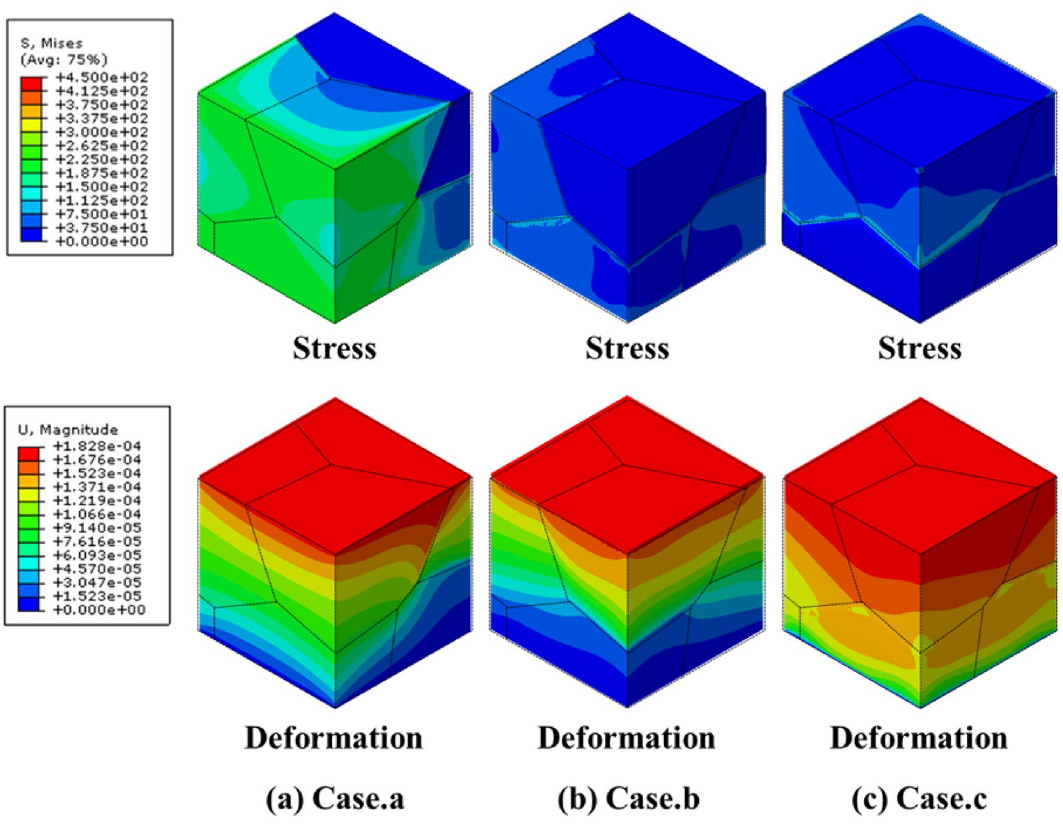
Figure 7. Stress and deformation FEM results of group